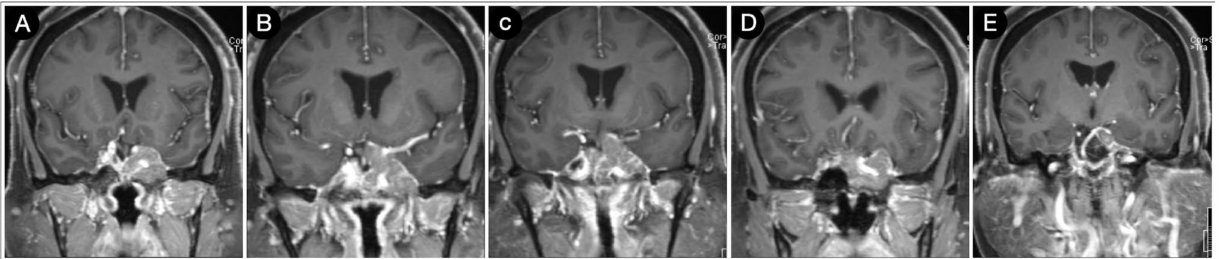
Figure 20. ( A – E ) Preoperative coronal T1-weighted contrast-enhanced MRI. Scale bar: 5 cm.